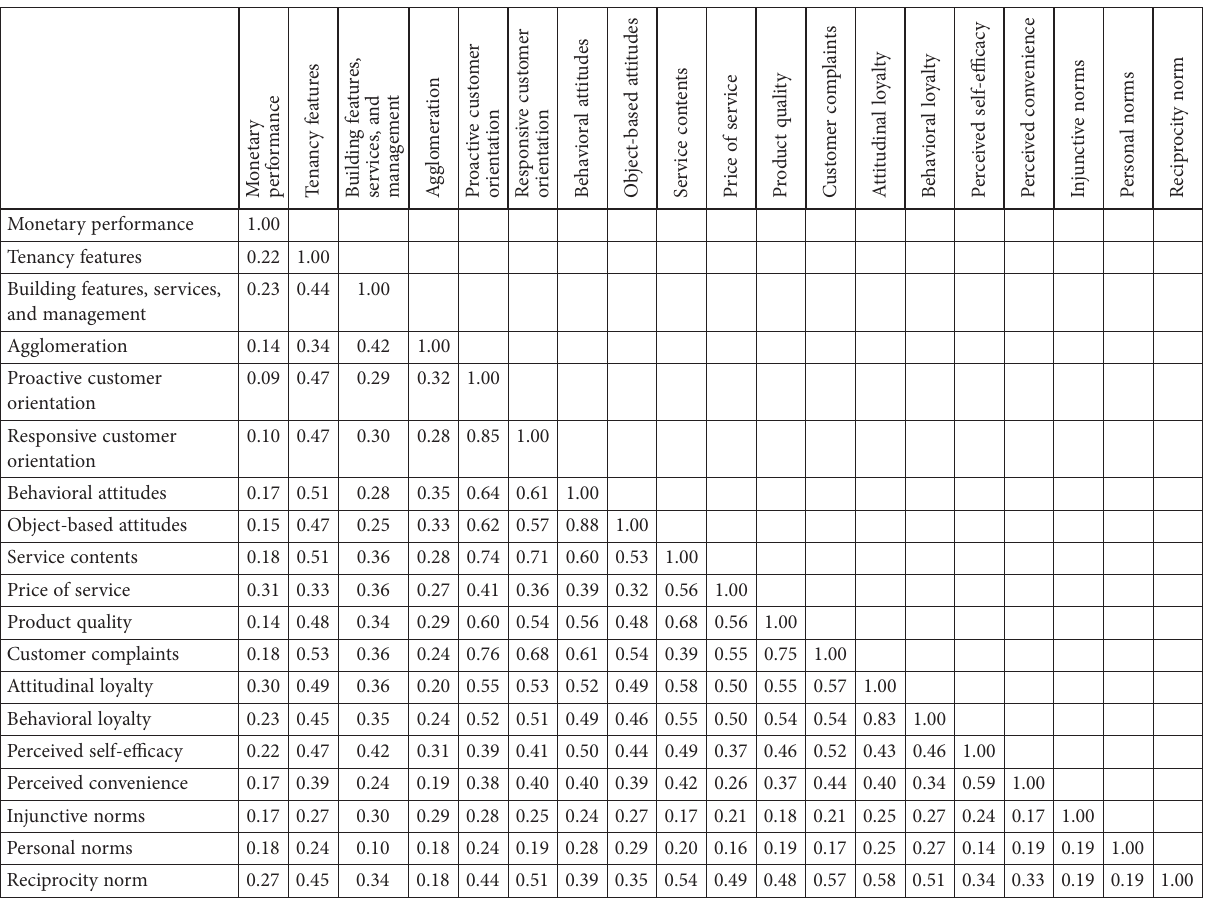
Table A1. Correlation coefficient of measurement